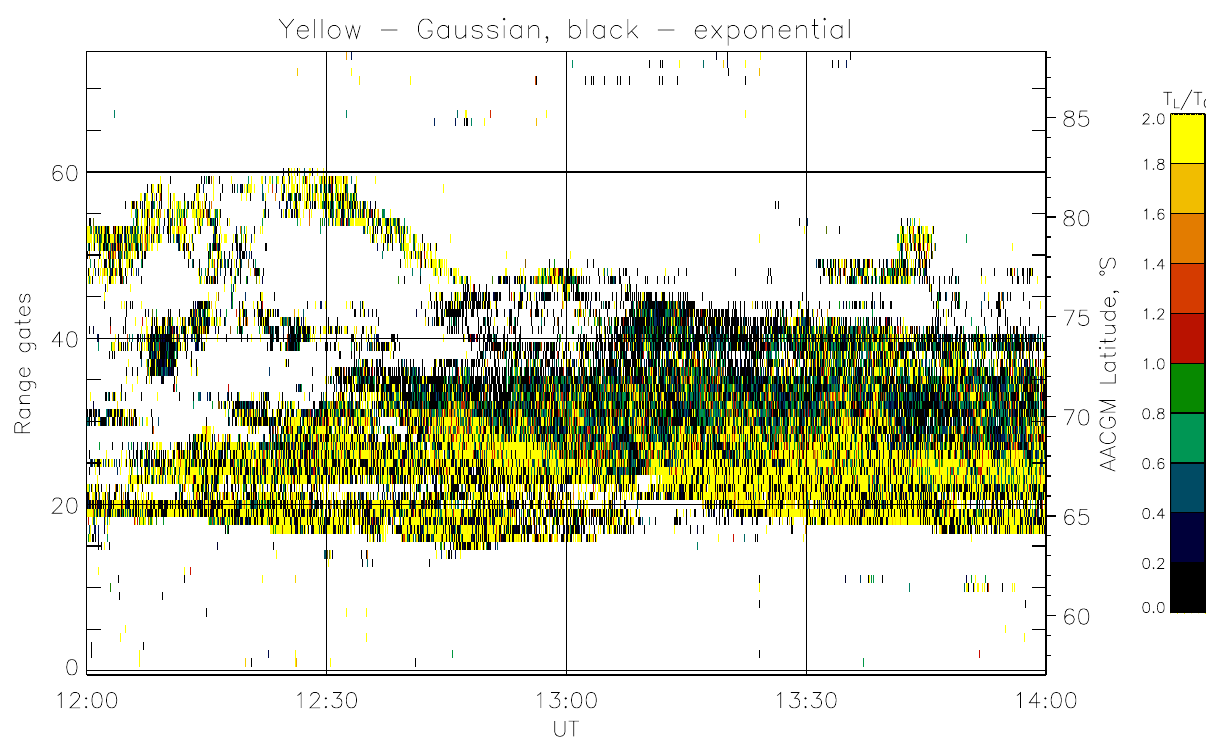
Fig. 14. Ratio between the Lagrangian correlation times, T L , and the Gaussian time constant, T G = T V = 1 /kδV , the correlation time related to the random drift of irregularities. Yellow colour corresponds mostly to Gaussian shaped ACF power while black shading depicts mostly the exponential shape.